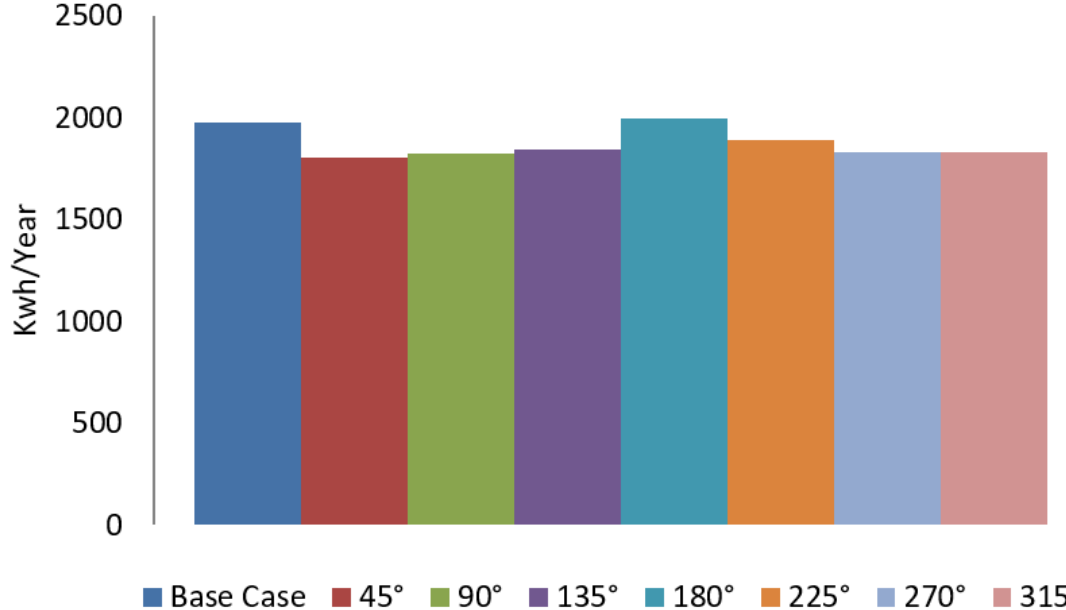
Figure 6. Energy consumption (heating loads) to sustain thermal comfort for different